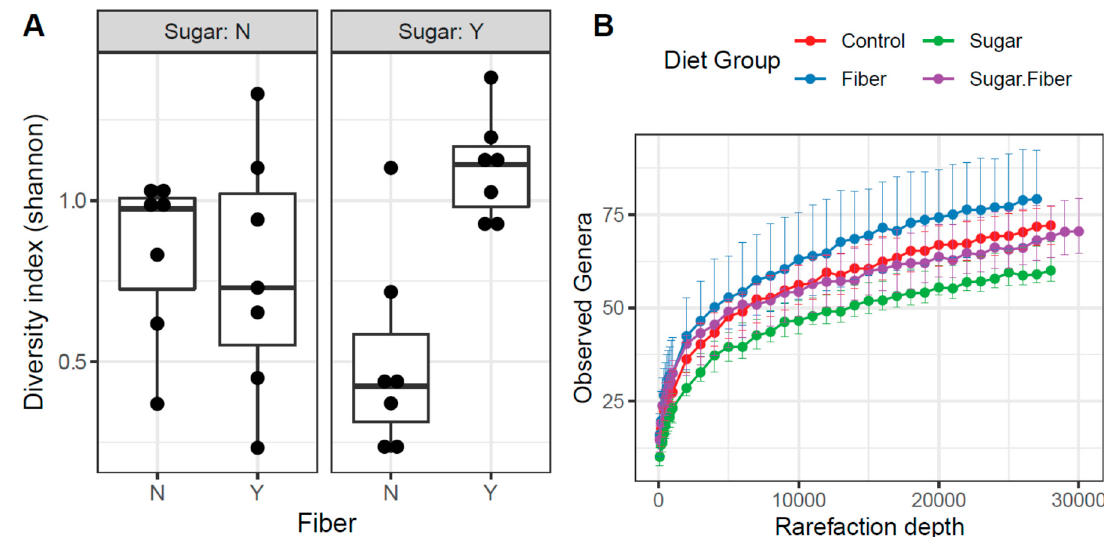
Figure 4. ( A ) Interactive effects of Sugar and Fiber on alpha diversity (Shannon Index) of murine dental microbiomes. The Sugar + Fiber group demonstrated an increase in community diversity compared to the Sugar group alone. N = absence of additive and Y = presence of additive. ( B ) Rarefaction curves display median number of observed genera for each dietary group. Rarefaction was performed using genus-level summary at depths of 100 to 30,000 with steps of 100 from 100 to 1,000 counts, and then steps of 1000 from 1000 to 30,000.